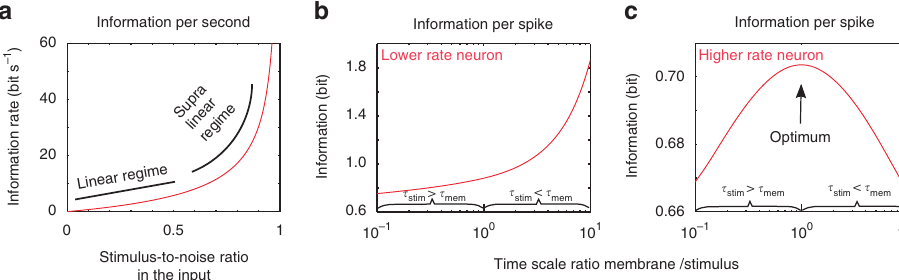
Figure 4 | Nonlinear properties of neural information content. ( a ) The information rate per spike increases monotonically with input stimulus-to-noise ratio (SNR). In the low SNR limit, information gain is proportional to input SNR (linear regime). The steepness of the information gain grows for increasing SNR (supralinear regime). ( b ) In low-rate neurons (high spiking threshold), the information per spike grows with the membrane time constant. ( c ) Higher rate neurons (low threshold to variance ratio) exhibit a maximum in information transmission if the time scales of stimuli and membrane match each other, t mem ¼ t stim . Parameter values as in Table